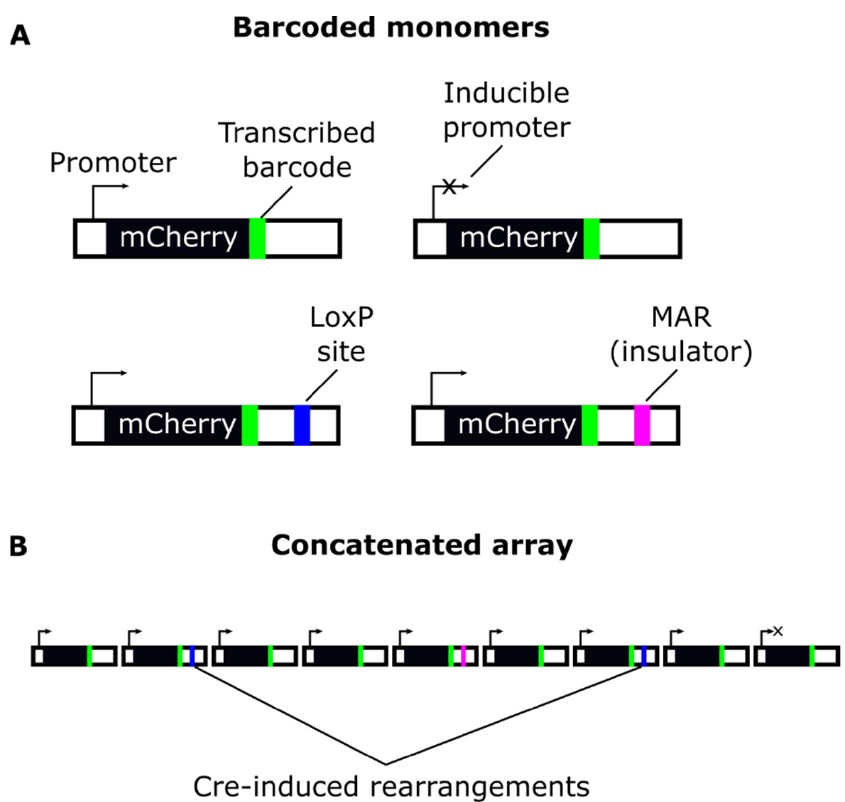
Figure 5. Barcoded reporter for concatenation of expressed monomers to study RIGS mechanisms. ( A ) Types of barcoded monomers. ( B ) Transfection of monomers in specific proportions (e.g., 10:1:1:1, where 10 is the standard monomer) could be used to create unique concatenated arrays for RIGS analysis by RNAseq and other methods. Transfection of the cells with Cre-recombinase would change the order and number of